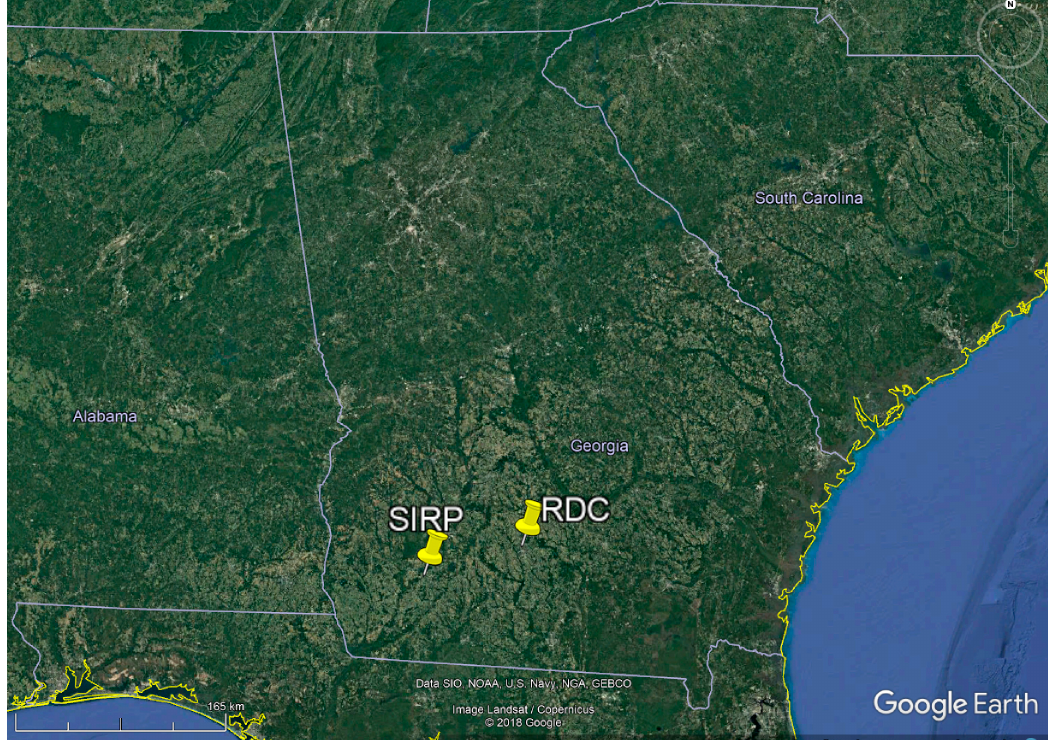
Figure 1. Image from Google Earth showing the location of the two fields (RDC and SIRP).